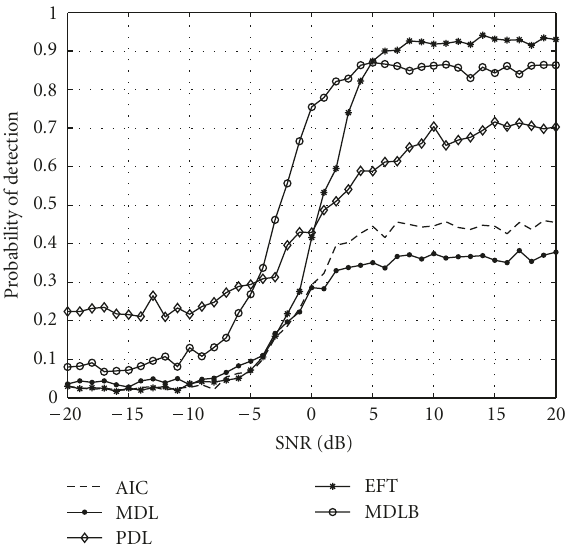
Figure 7: Probability of detection for the EFT (predefined P fa = 1%), the MDL, the AIC, the PDL, and the